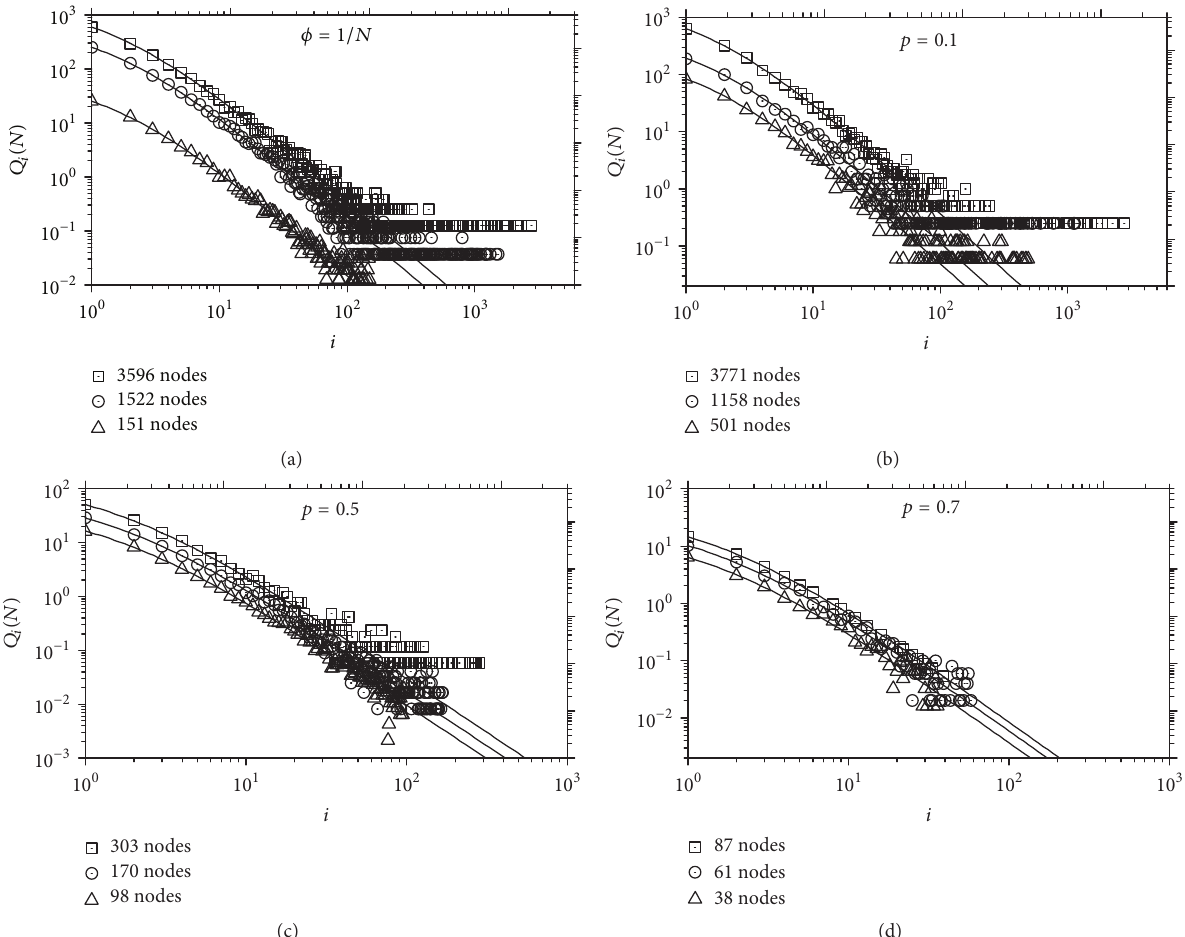
Figure 6: In-degree distributions of islands with different sizes founded in the networks generated with the proposed model with 𝜙 = 1/𝑁 (a) and 𝑝 = 0.1, 0.5 , and 0.7 (b–d). The solid line is the plot of